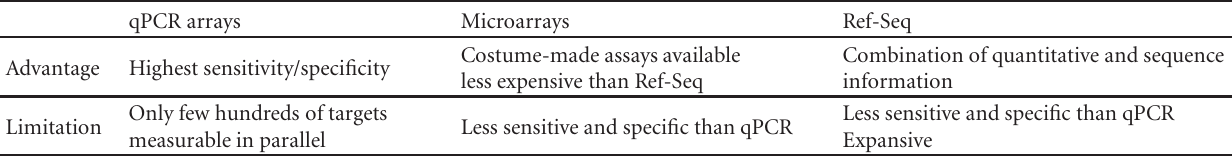
Table 1: Advantages and limitations of transcriptomics